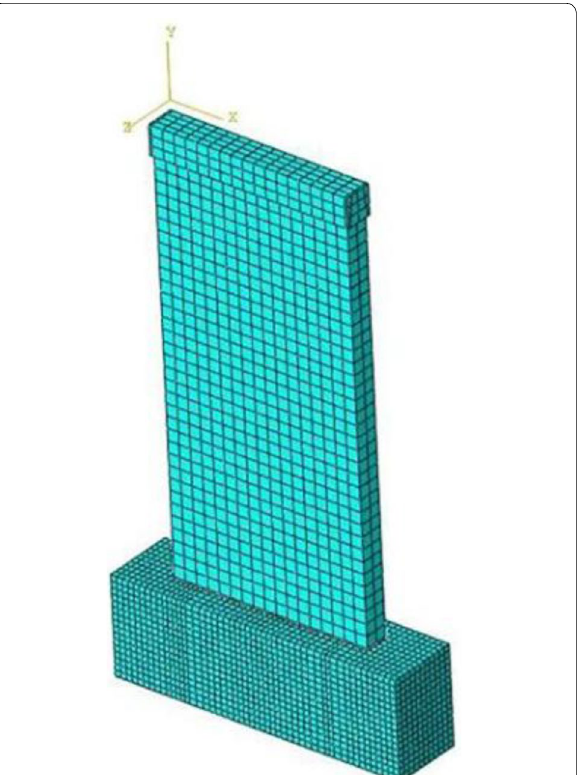
Fig. 11 Material modeling of a strengthen elastic–plastic model and b ideal elastic–plastic model. Fig. 12 Overall configuration of FE